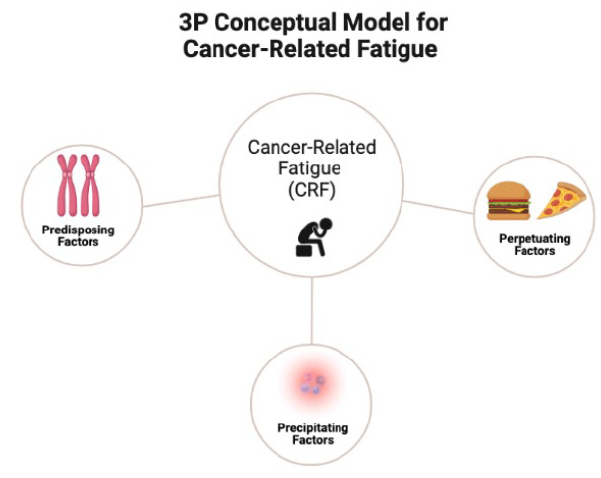
Figure 1. The 3P conceptual model for cancer-related fatigue.